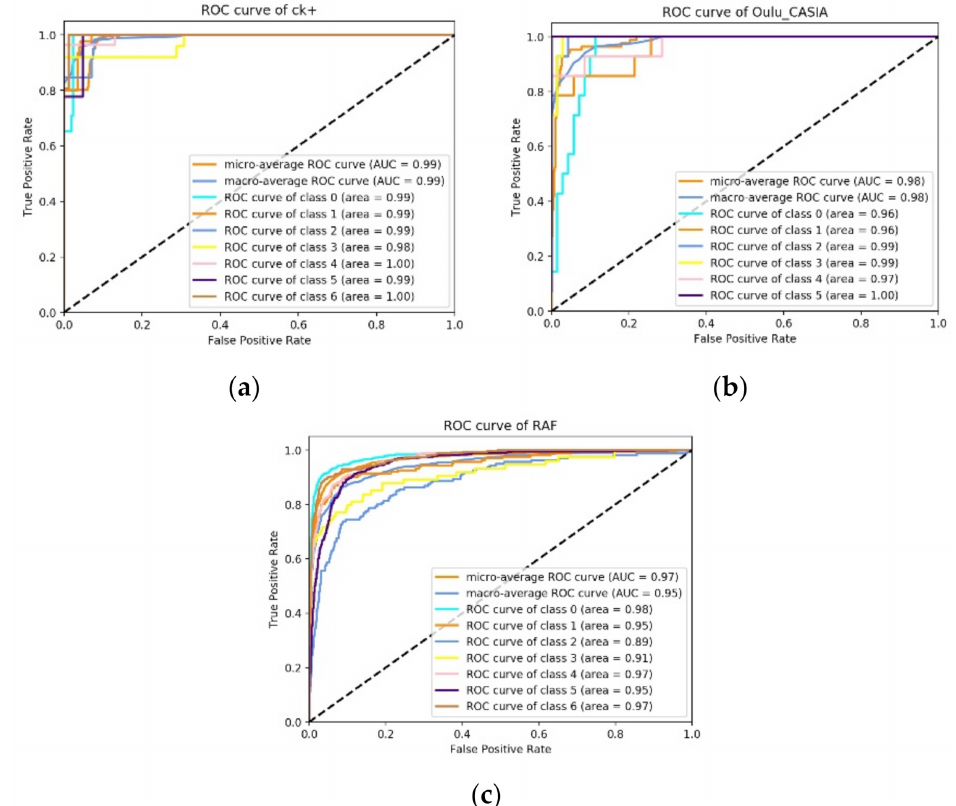
Figure 6. ROC curves on the CK+, Oulu–CASIA, and RAF–DB datasets. In each graph, the top two lines respectively represent the macro-average ROC curve and micro-average ROC curves of the dataset. In subplot ( a ) (i.e., the CK+ dataset), categories 0–6 correspond to happiness, anger, disgust, fear, sadness, contempt, and surprise, respectively; in subplot ( b ) (i.e., the Oulu–CASIA dataset), classes 0–6 correspond to expressions of happiness, anger, disgust, fear, sadness, neutrality, and surprise, respectively; in subplot ( c ) (i.e., the RAF–DB dataset), classes 0–6 correspond to happiness, anger, disgust, fear, sadness, neutrality, and surprise,